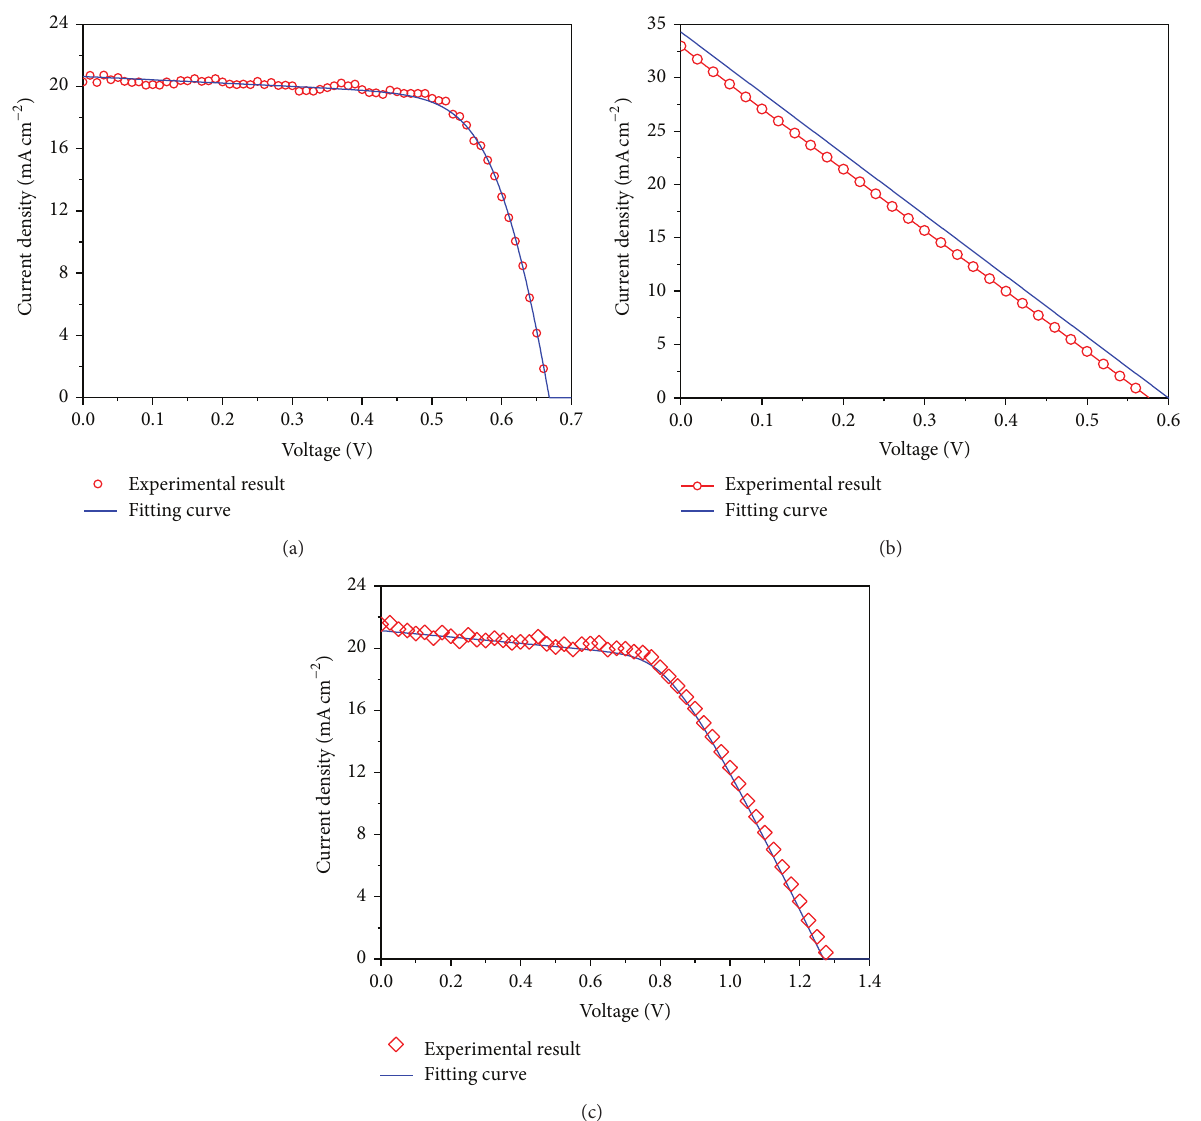
Figure 2: The experimental and fitting 𝐽 - 𝑉 curves of (a) single DSSC, (b) single TE, (c) series DSSC, and TE hybrid device.